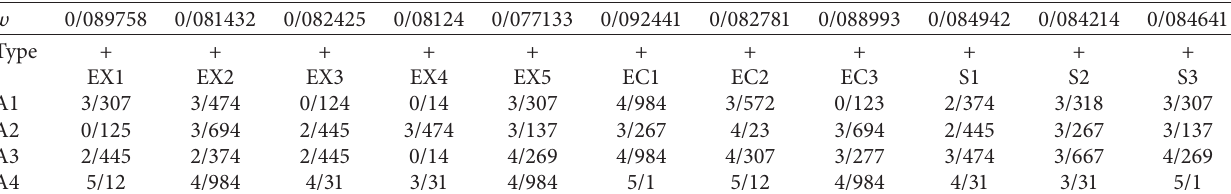
Table 8: Cumulative decision matrix.